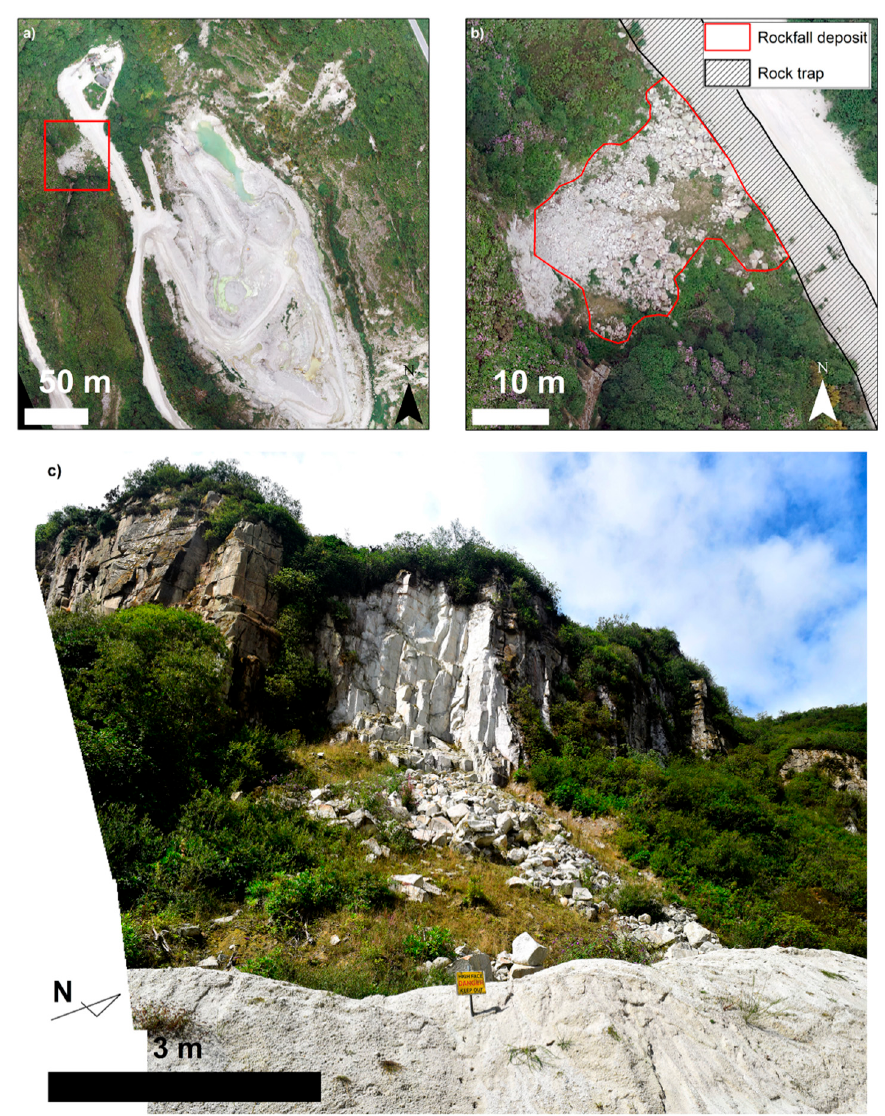
Figure 1. Location of the rockfall slope ( a ) aerial location of the case study position in the overall pit; ( b ) localised aerial view; ( c ) view from the base of the slope. The photographs were acquired in August 2018. Scale bar in ( c ) is indicative.